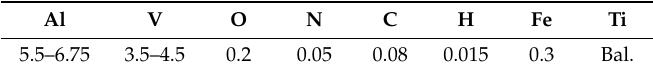
Table 1. Chemical compositions for Ti-6Al-4V used in the study (wt %).